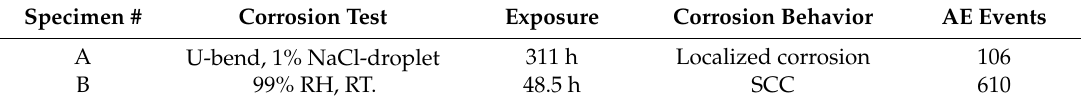
Table 3. Summary of the corrosion behaviors and AE results of two cases.